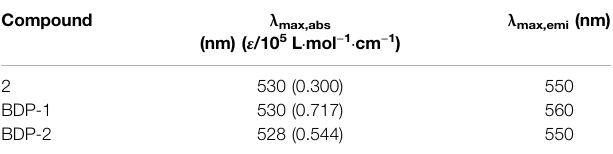
TABLE 1 | Absorption and emission data. a Compound